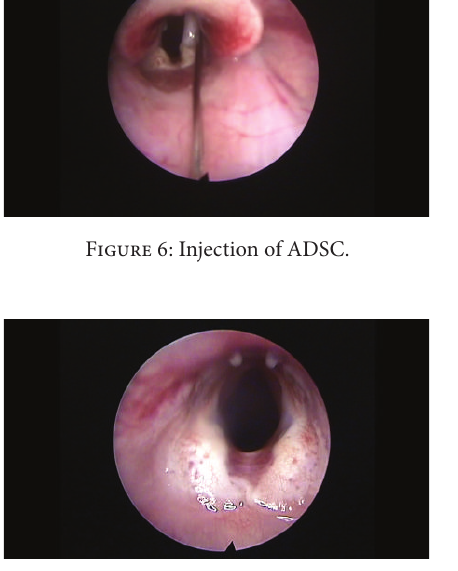
Figure 7: Vocal folds 3 months after the injection of ADSC.